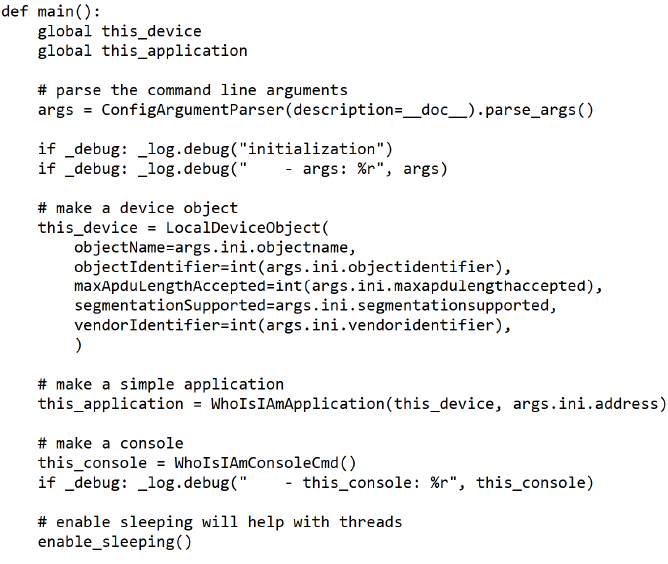
Figure 9. Detect the device by UDP communication protocol.